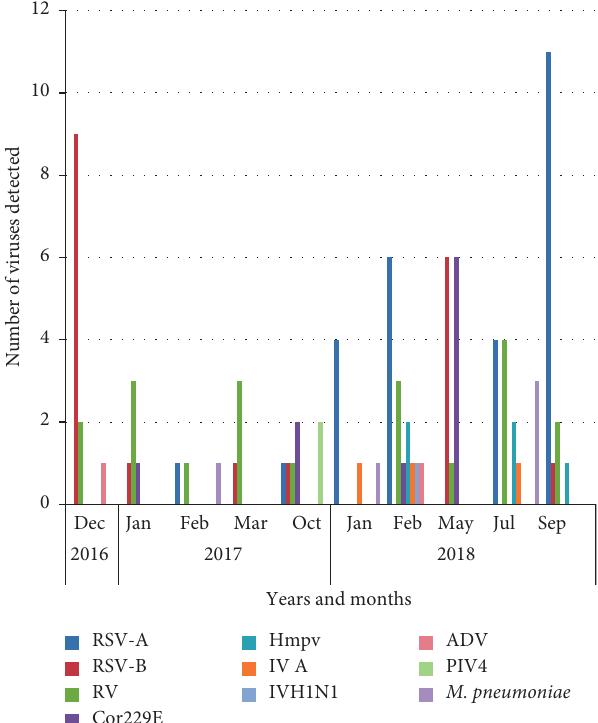
Figure 1: Detection of viruses and bacteria during the study period